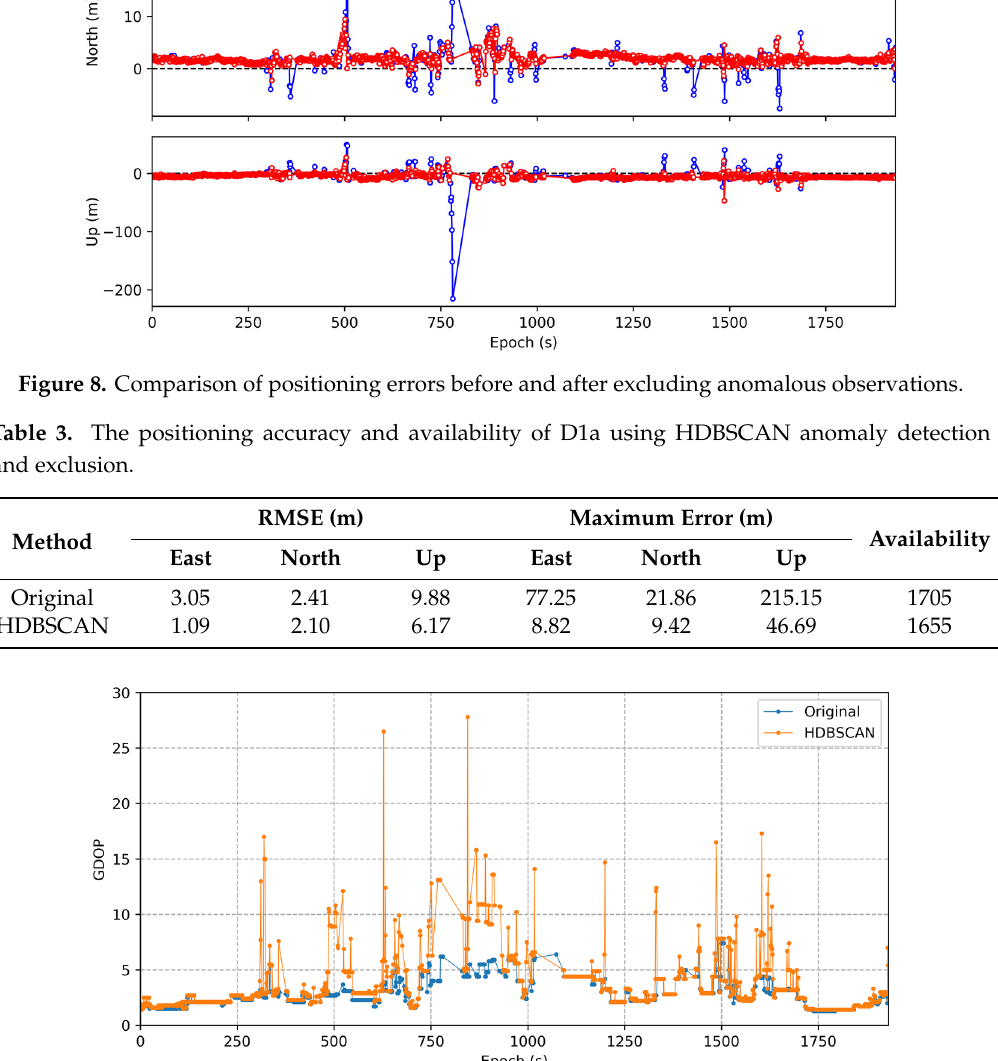
Figure 9. Comparison of geometric dilution of precision (GDOP) before and after excluding anomalous observations.